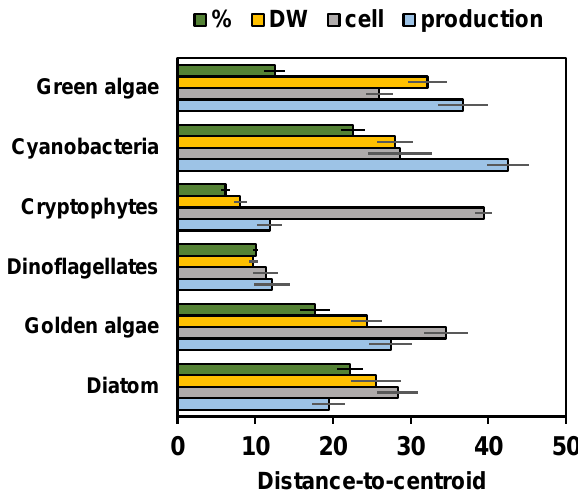
Figure 5. Permutational Analysis of Multivariate dispersion (PERMDISP) of ω -3 and ω -6 PUFA across each phytoplankton class (contribution (%), biomass content (DW), cell content (cell), and